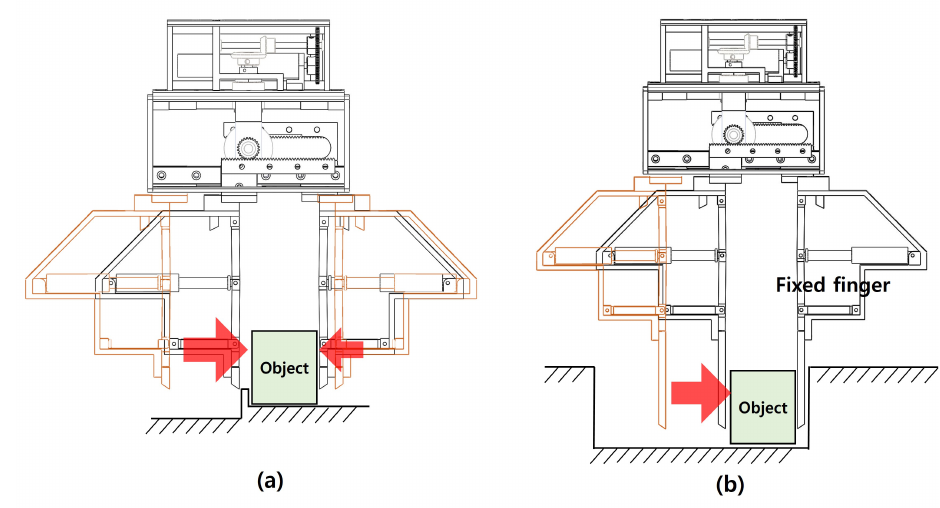
Figure 3. Grasp modes using differential gear actuator. ( a ) Jammed grasp mode. ( b ) Fixed finger grasp mode.